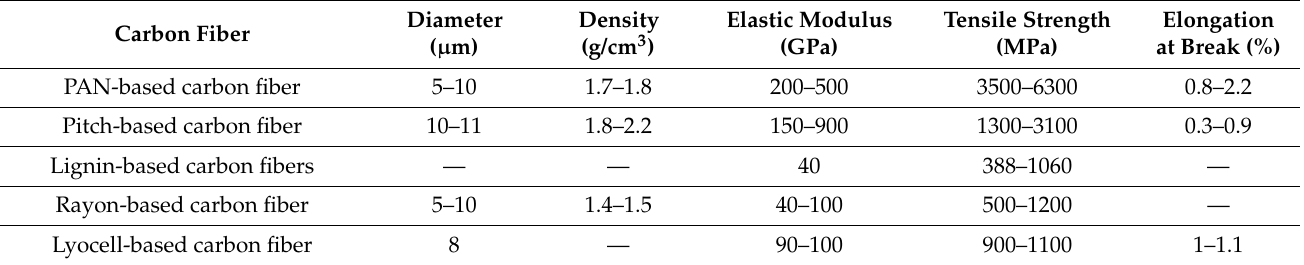
Table 2. Properties of carbon fibers from different precursors (Adapted with permission from Ref.